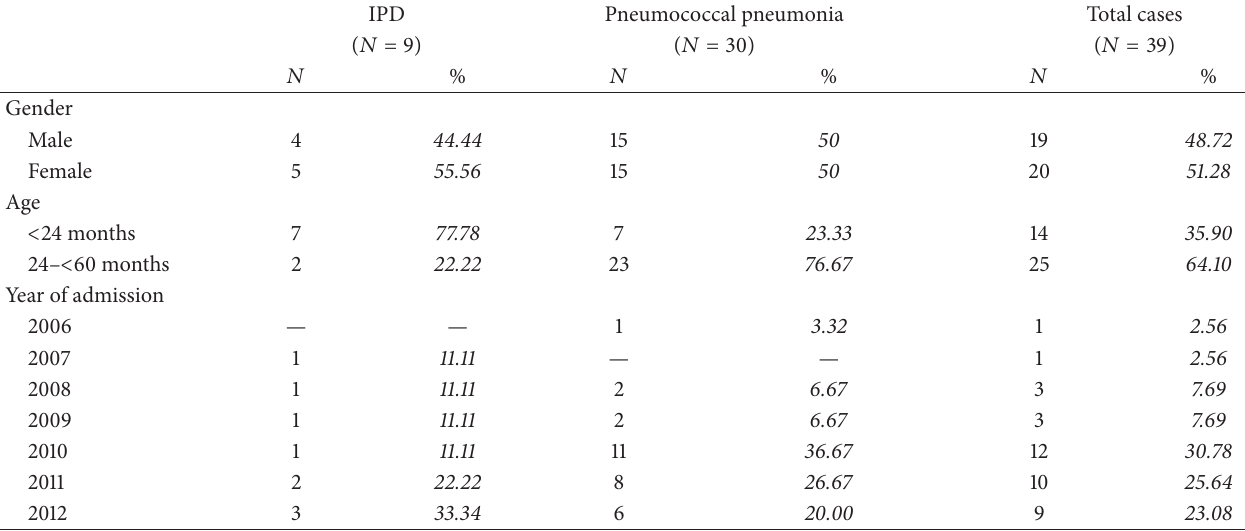
Table 1: Cases of IPD and pneumococcal pneumonia recruited among children hospitalized between June 2006 and December 2012 in the Puglia region, by gender, age, and year of